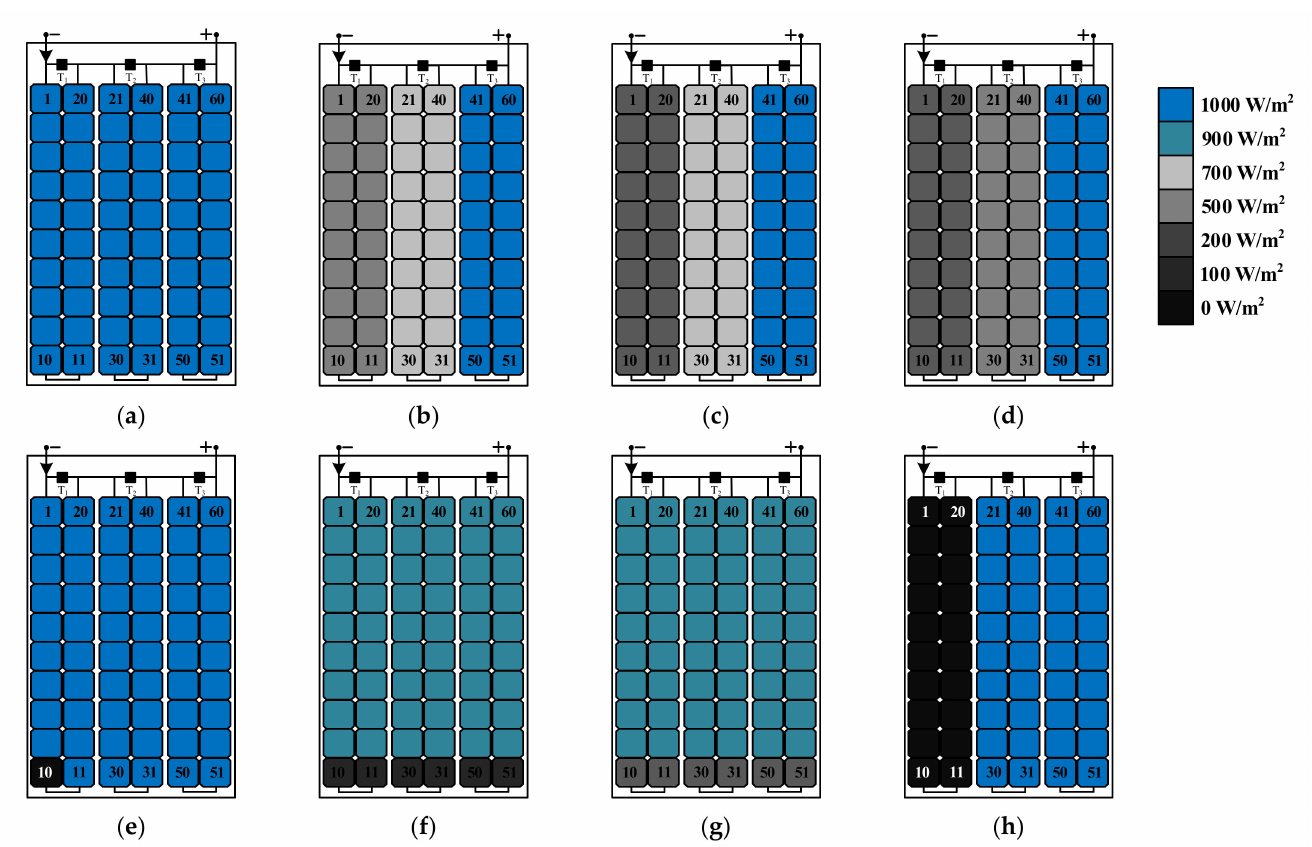
Figure 10. General layout of MATLAB model.